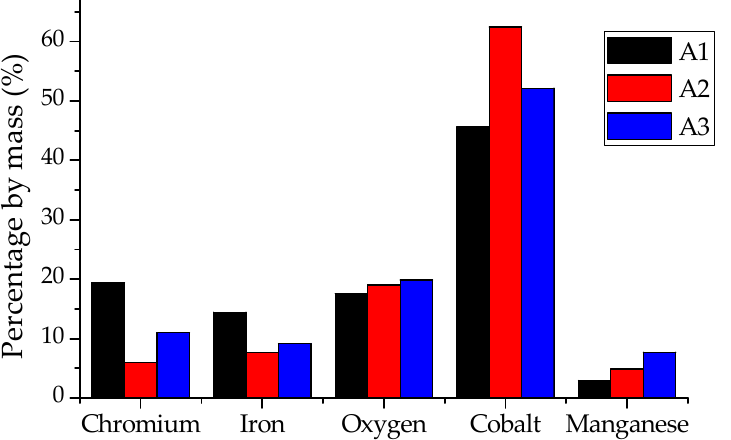
Figure 9. Semi-quantitative EDS data for the surface of samples A1, A2 and A3 after oxidation heat treatment at 800 °C for 300 h.